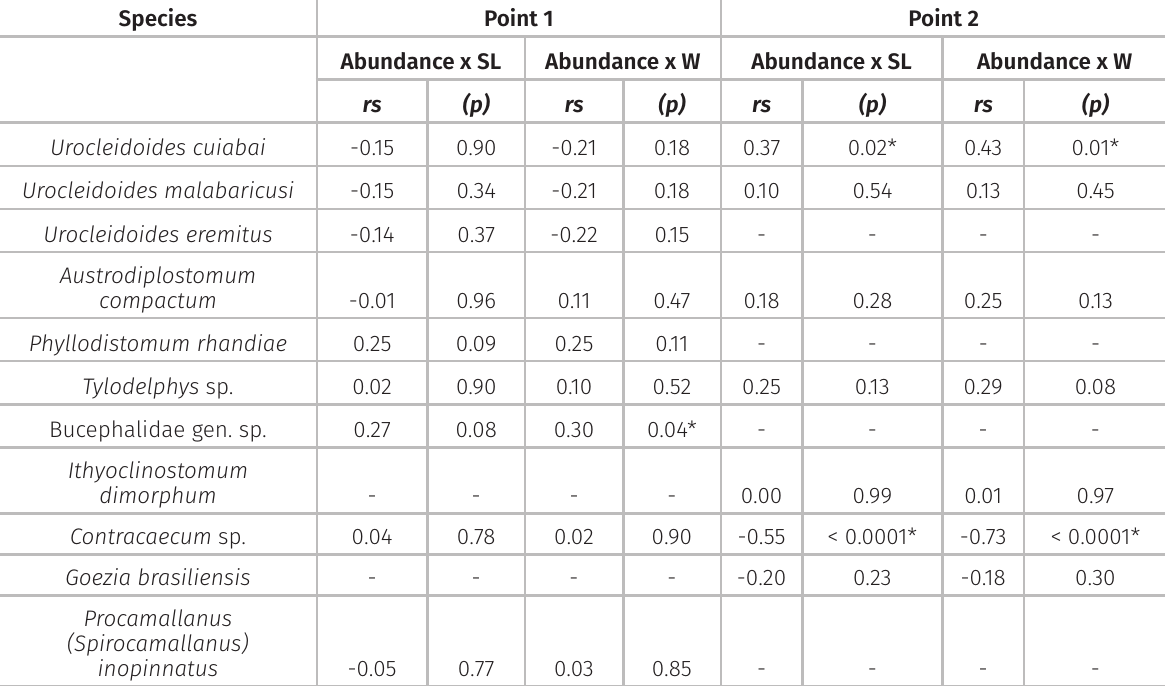
Point 1 = Batalha River channel. Point 2 = Detention basin managed by the Department of Water and Sewage (DAE) of Bauru. rs = Spearman rank correlation